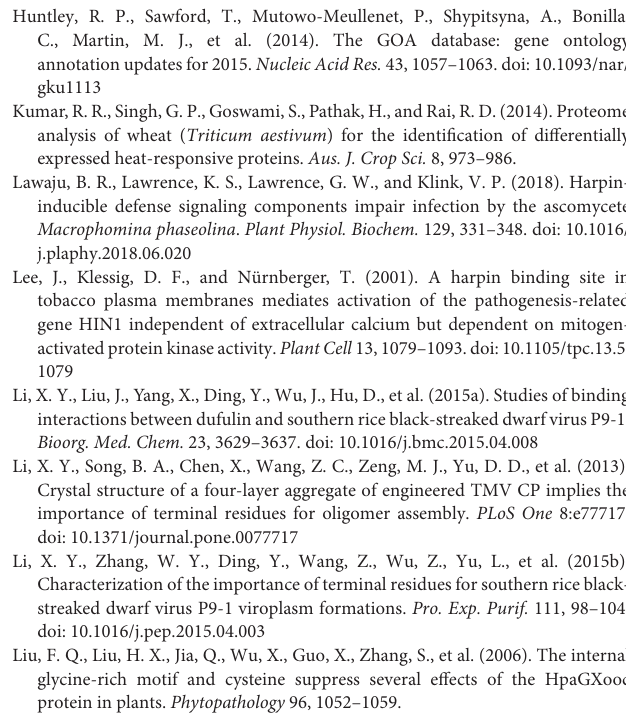
Supplementary Figure 1 | Nucleotide sequence and amino acid sequence of HrBP1 sequence from Nicotiana tabacum . Supplementary Table 1 | Primer sequences used in